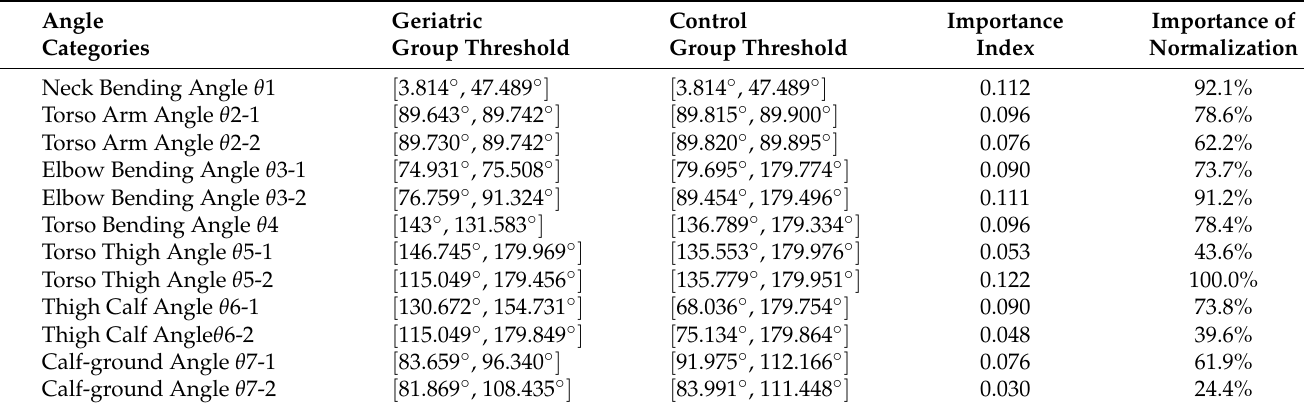
Table 3. Comparison of the threshold ranges for each angle in the elderly and control groups.